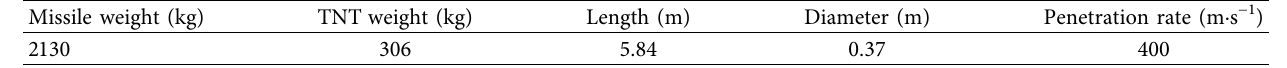
Table 1: Technical parameters of earth penetrator.